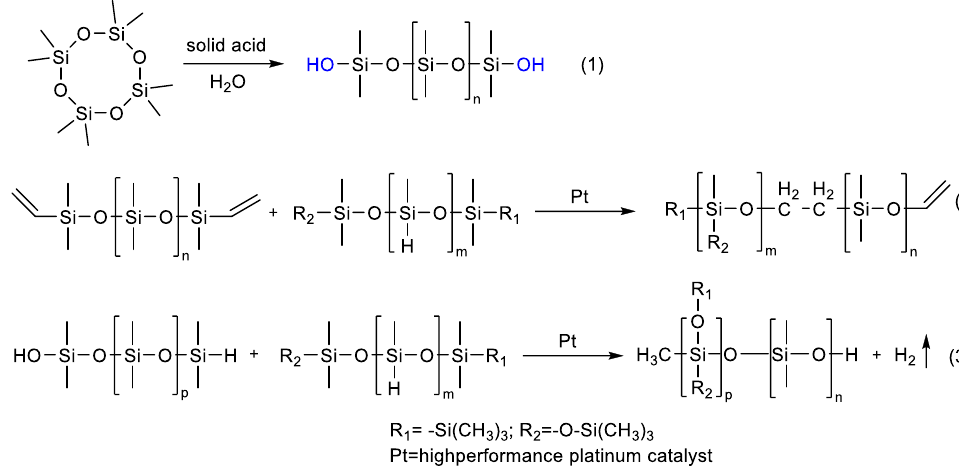
Figure 28. Preparation of hydroxyl-terminated polydimethylsiloxanes (OH – PDMS) and polysilox- ane foam (SIF).